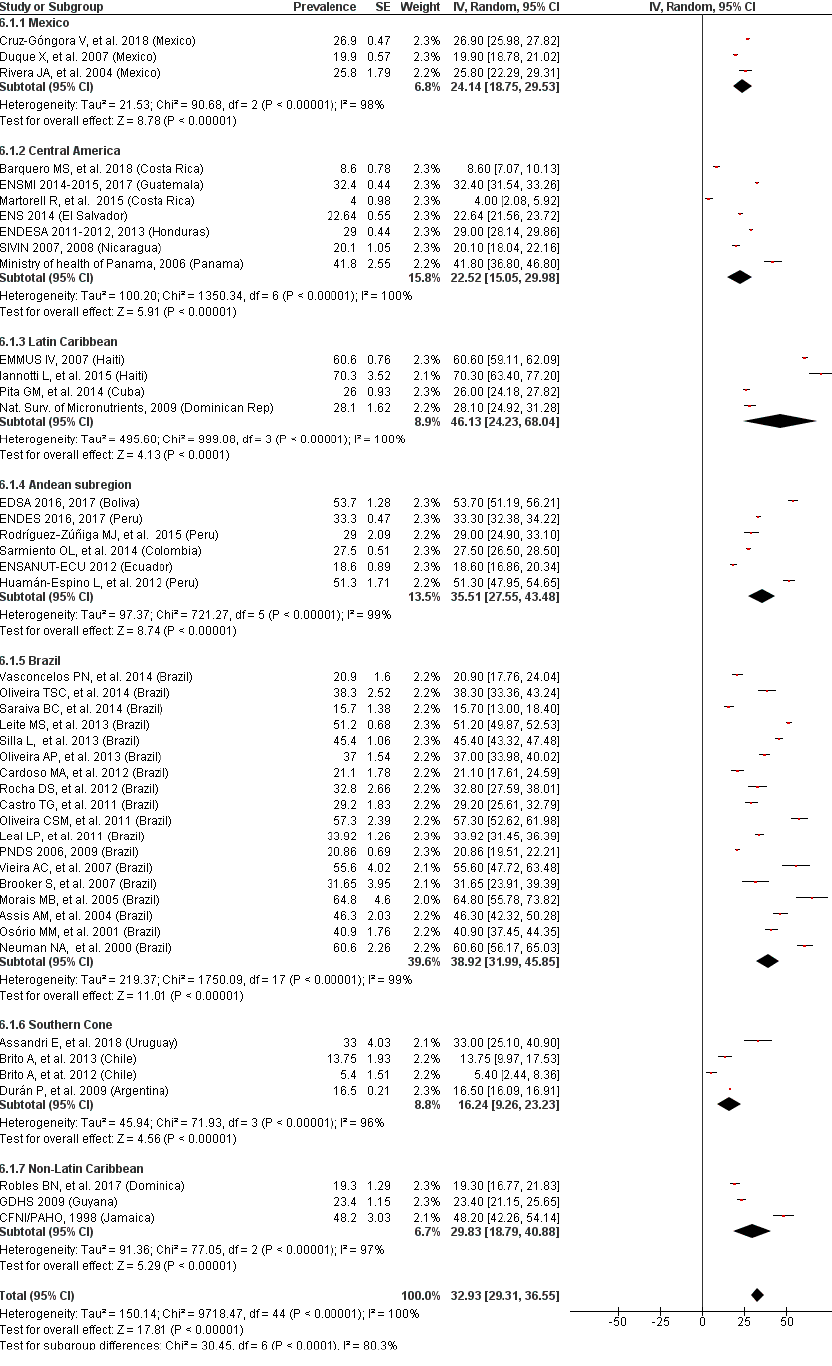
Figure 7. Prevalence of anemia in preschool children by LAC region.